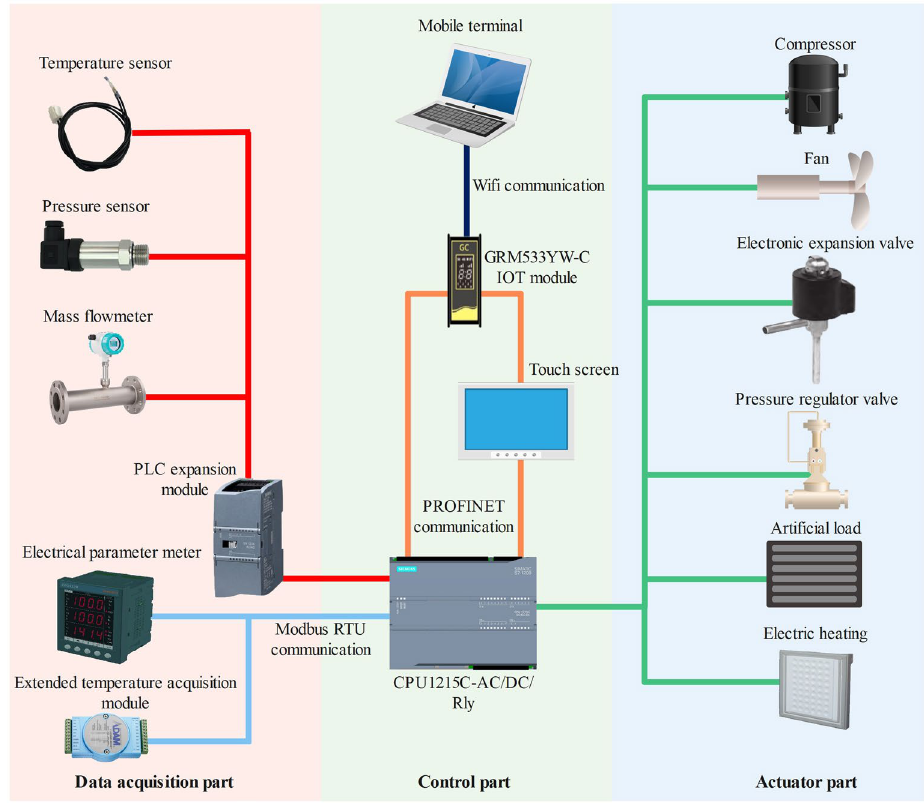
Figure 2. CO 2 transcritical refrigeration experimental platform control system structure.